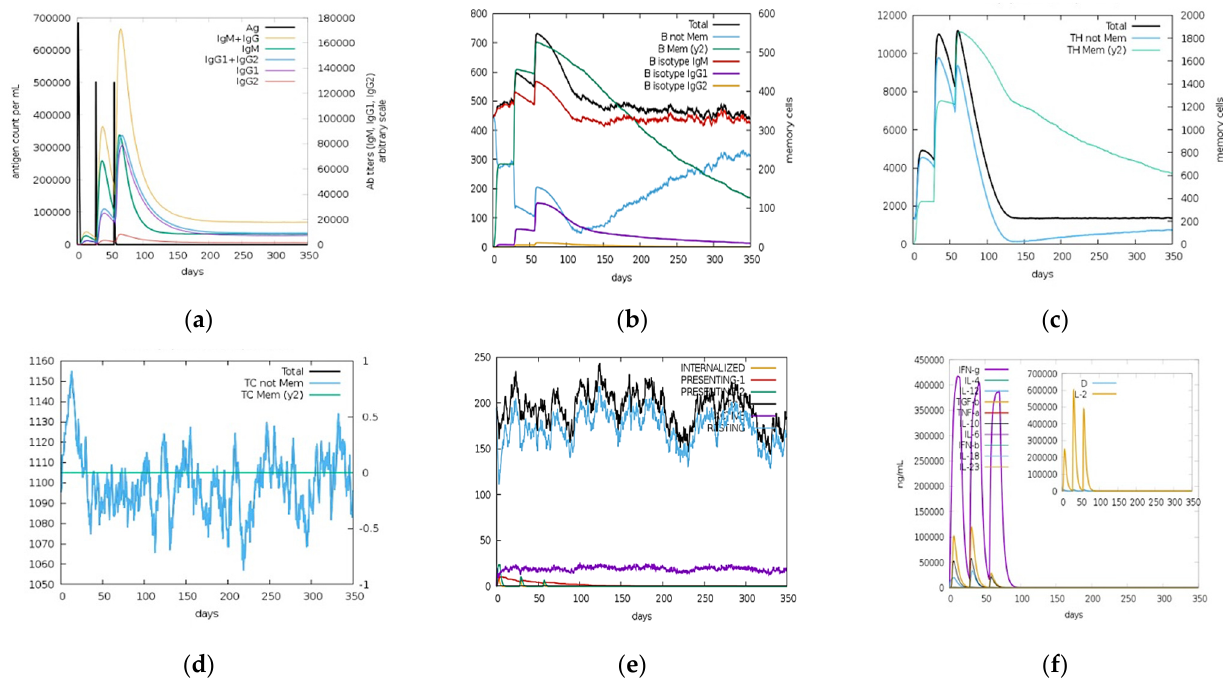
Figure 10. C-ImmSim server predictions for NS1 protein: ( a ) immunoglobulins (IgG1, IgG2, IgM, IgG, IgM, and antigens); ( b ) memory cell (B-cell) population; ( c ) helper T cell (HTL) population; ( d ) cytotoxic T cell (CTL) population; ( e ) macrophage count per state; ( f ) cytokine and interleukin (IL) production with Simpson index (D) of the immune response.